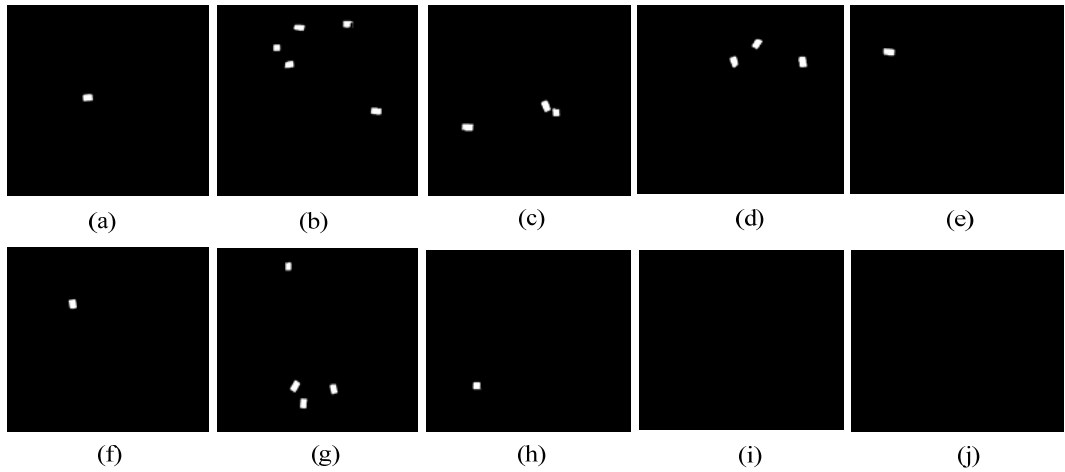
Figure 23. The packaged regions in the normal cases corresponding to the images shown in Figure 22a–j.